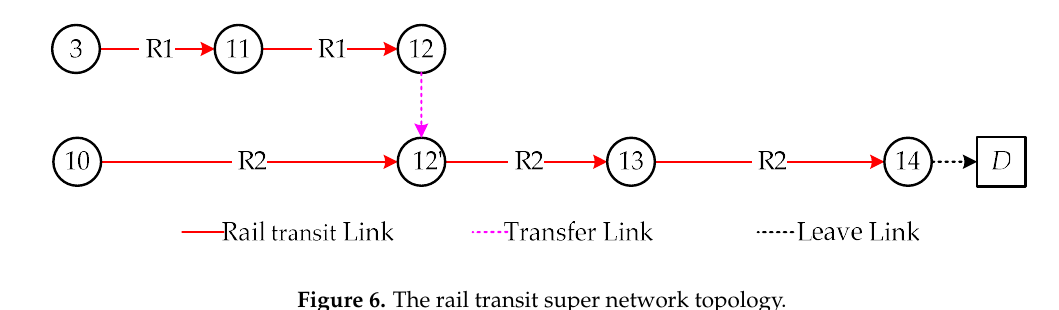
Figure 6. The rail transit super network topology.